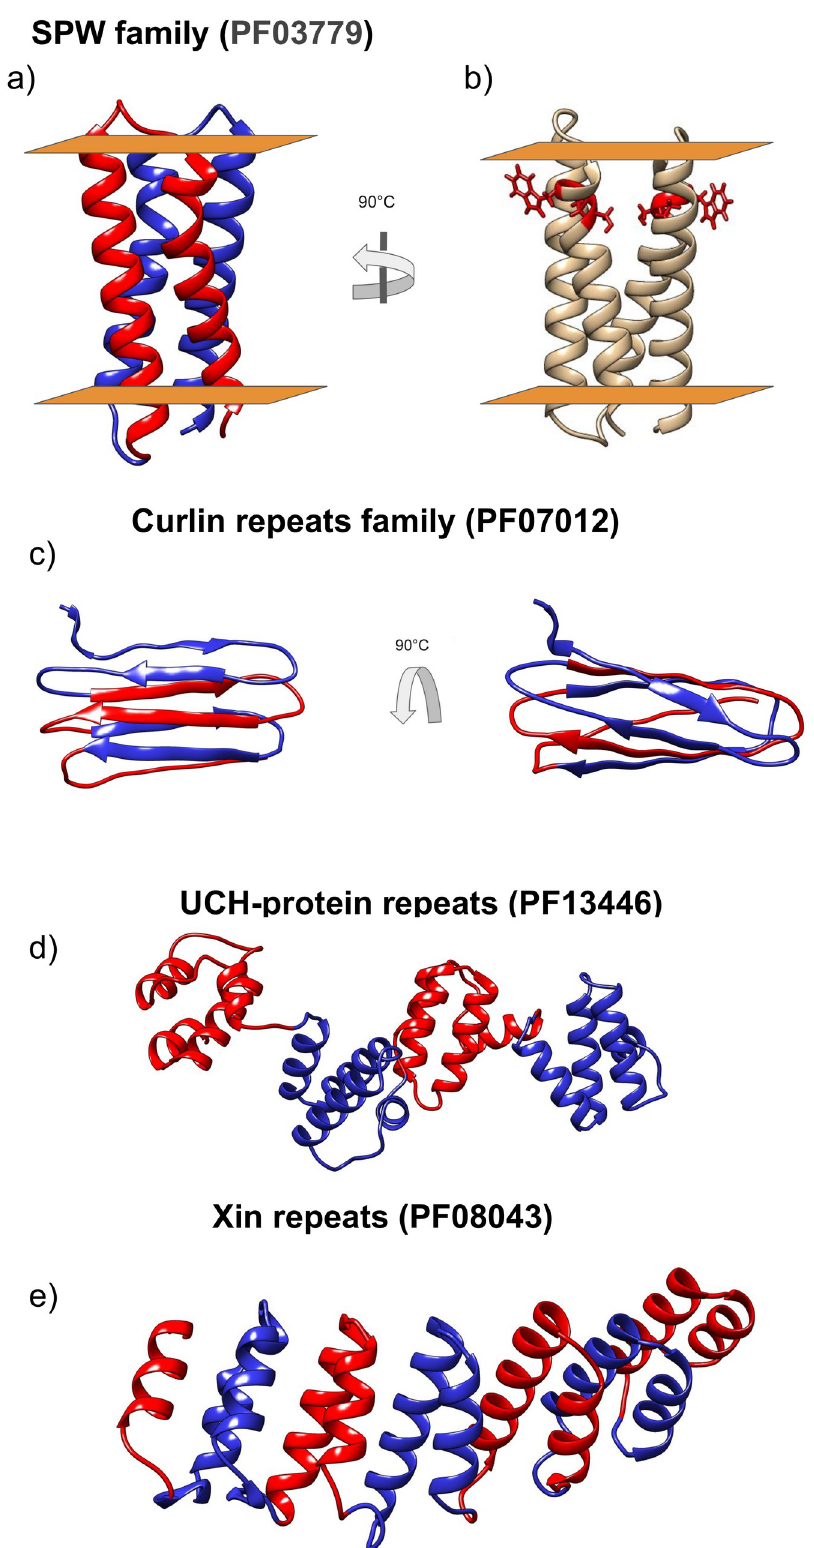
Fig 11. Selected models. The different protein units are coloured in red and blue. a) SPW, b) SPW in red the “SPW” motif c) Curlin d) UCH-protein are shown and e) Xin repeat. https://doi.org/10.1371/journal.pcbi.1008798.g011 PLOS Computational Biology | https://doi.org/10.1371/journal.pcbi.1008798 April 15,